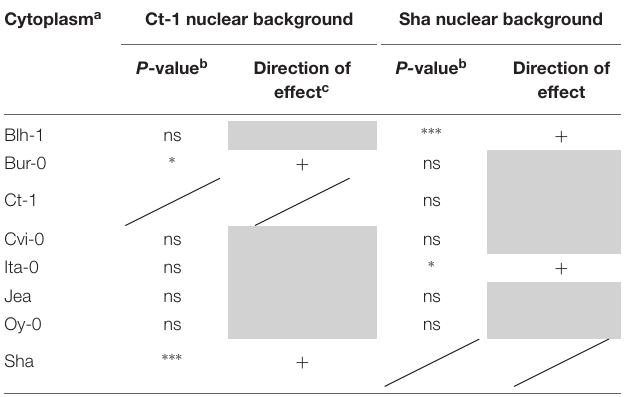
TABLE 4 | Impact of foreign cytoplasms on germination after CDT in the Sha and Ct-1 nuclear backgrounds. Cytoplasm a